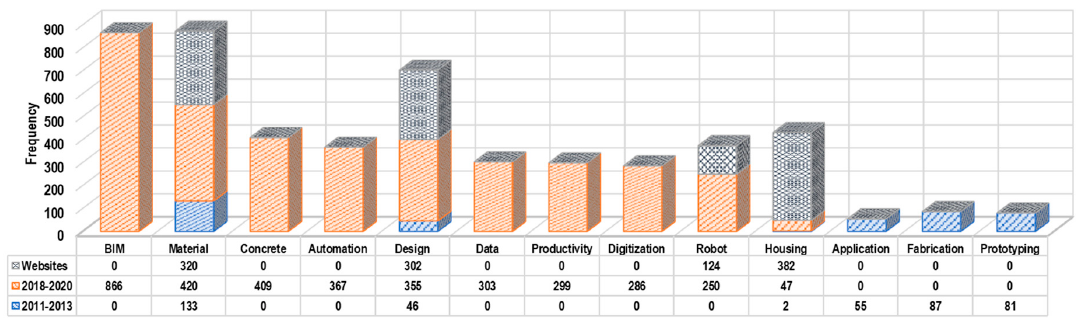
Figure 11. Comparison of the frequency of keywords within the selected documents, which include scholarly articles and selected commercial companies’ websites.